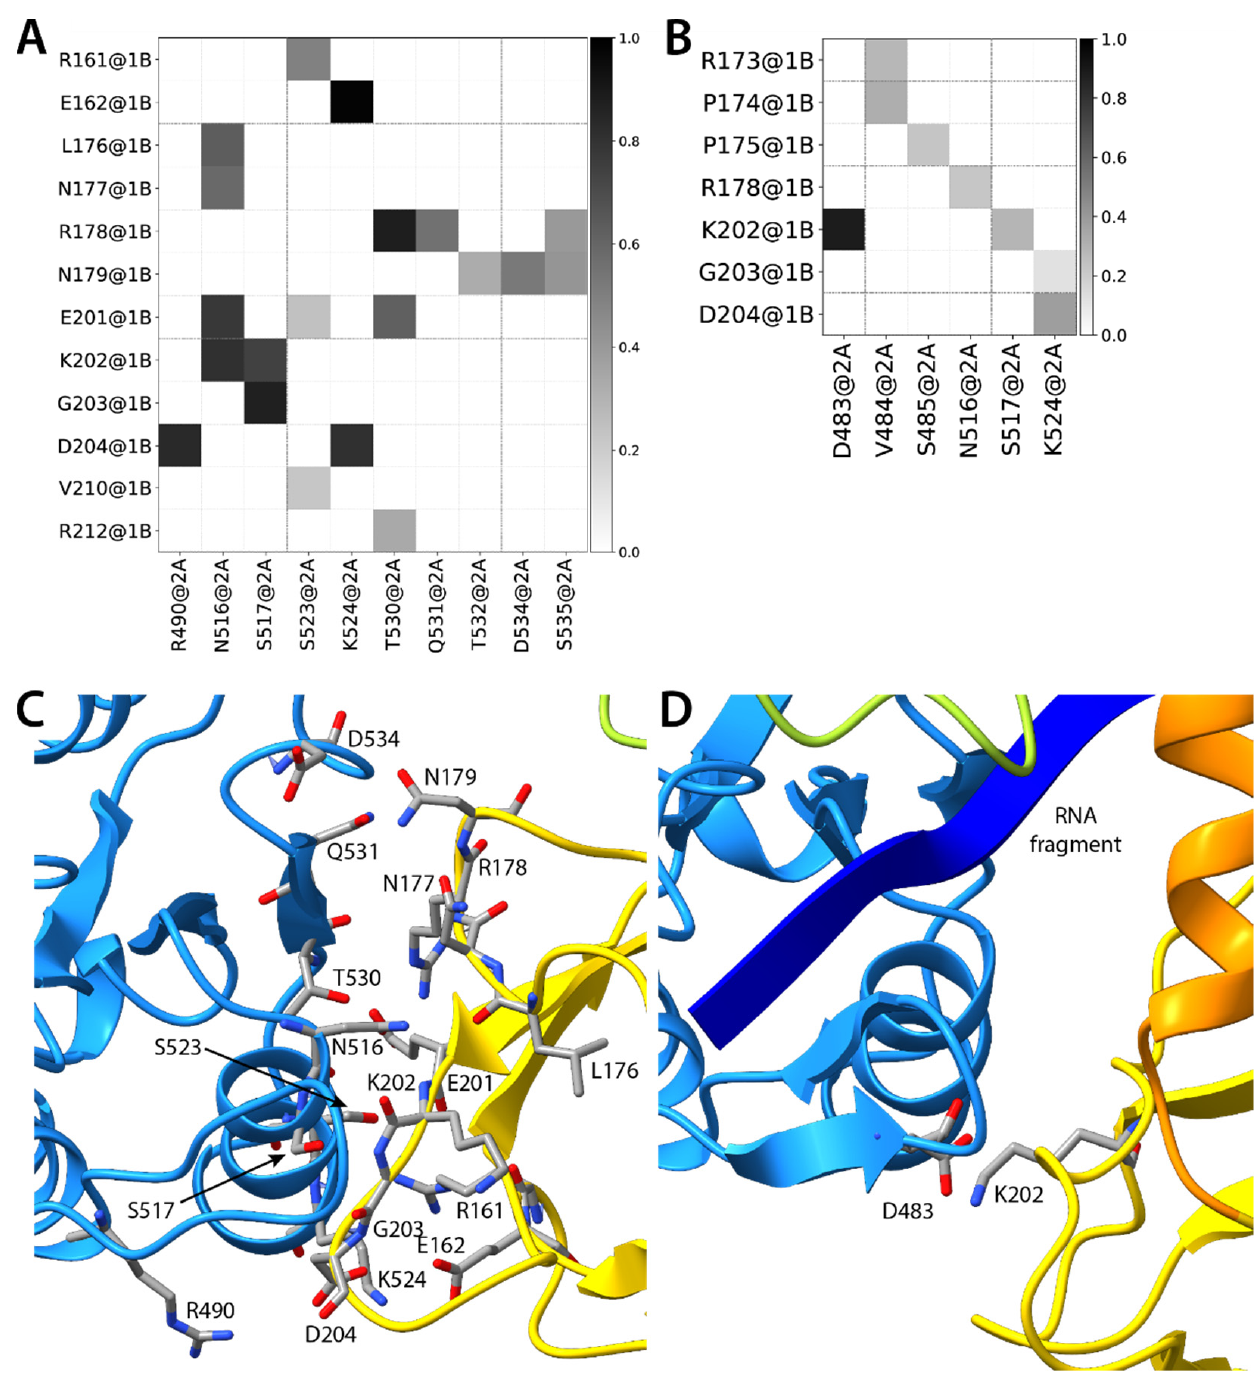
Figure 6. Plot of the interface contact matrix between Domains 1B and 2A in RNA-free ( A ) and RNA-engaged ( B ) NSP13. Contacts are colored from white to black if they were observed in 0% or 100% of the simulation time, respectively. In Panels ( C ) (RNA-free) and ( D ) (RNA-engaged), a detail of the 1B–2A interface taken from the representative structure of the most populated cluster is given. The ribbons are colored as in Figure 1C, while the residues involved in a contact lasting for at least 50% of the simulation time are reported as sticks colored according to the atom type.